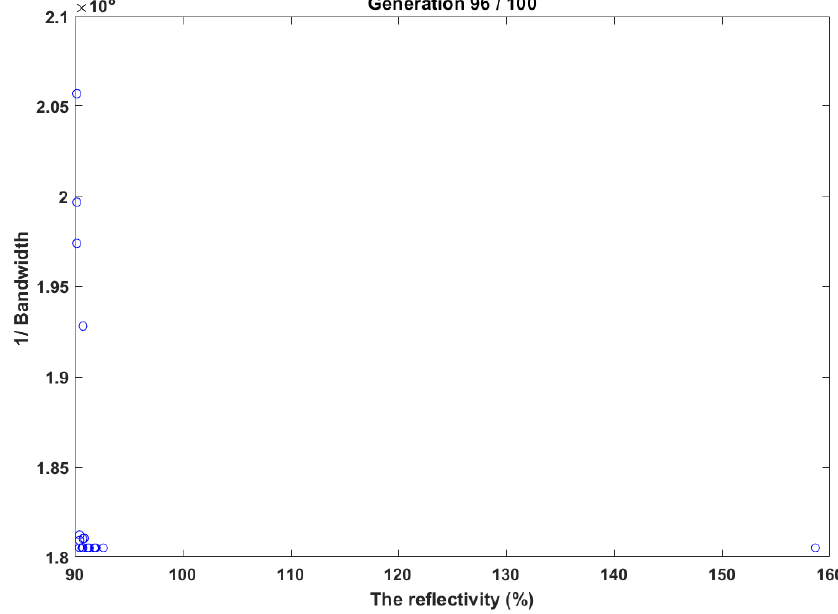
Figure 5. Testing of NSGA-II for increasing the reflectivity and increasing the bandwidth.